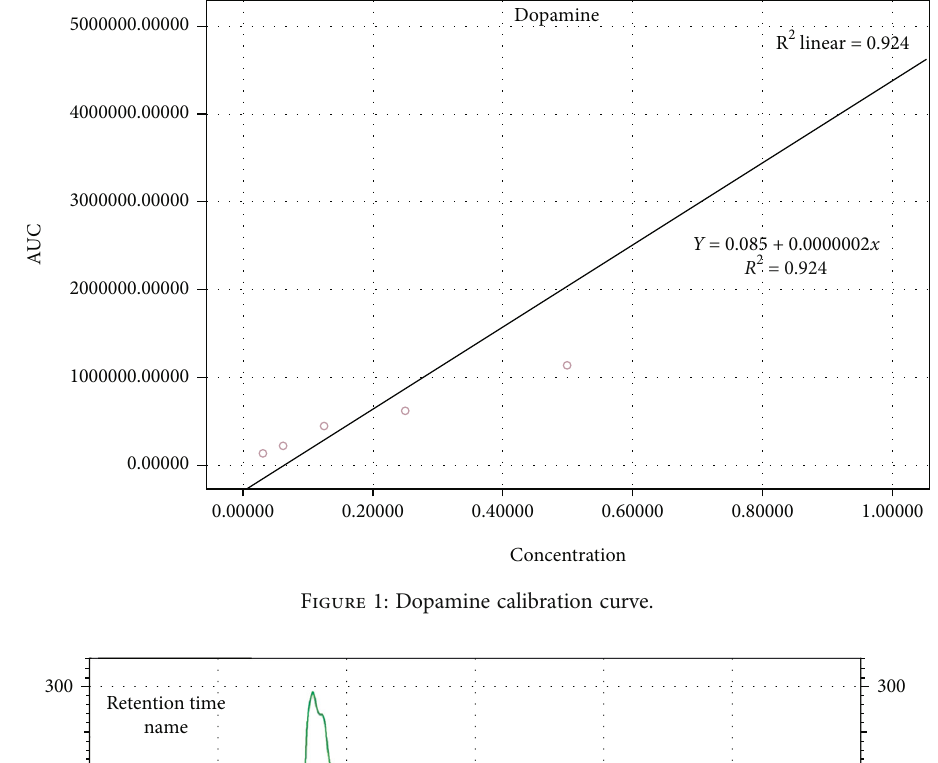
Figure 1: Dopamine calibration curve.